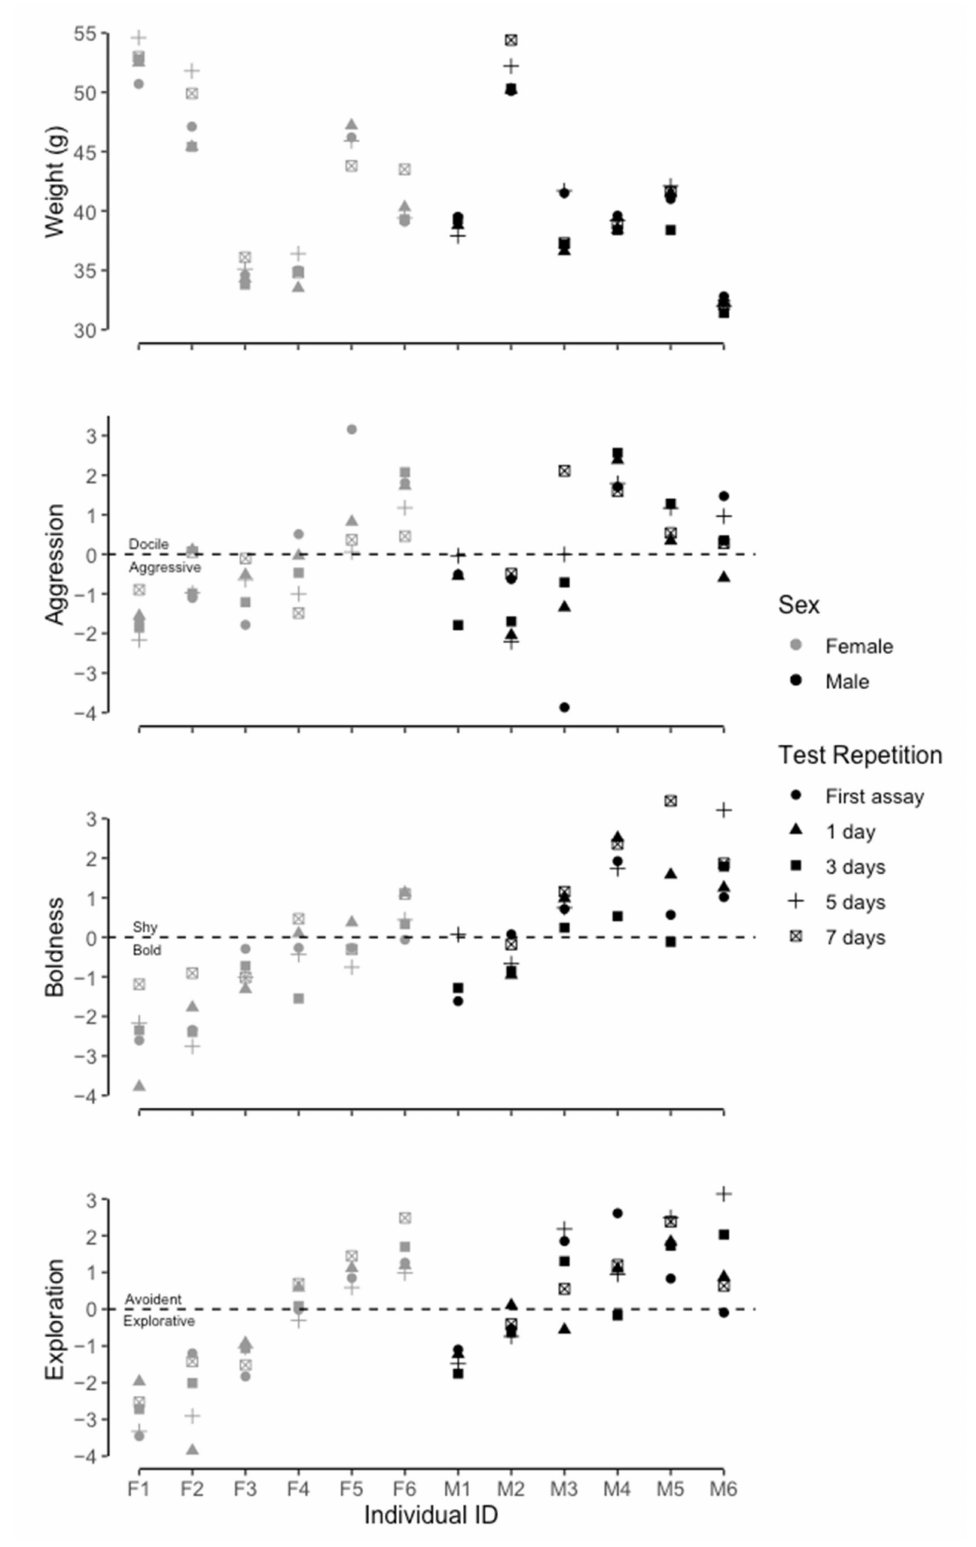
Figure 2. Between and within individual variation in body mass (g), and PCA values from Aggression, Boldness and Exploration tests,